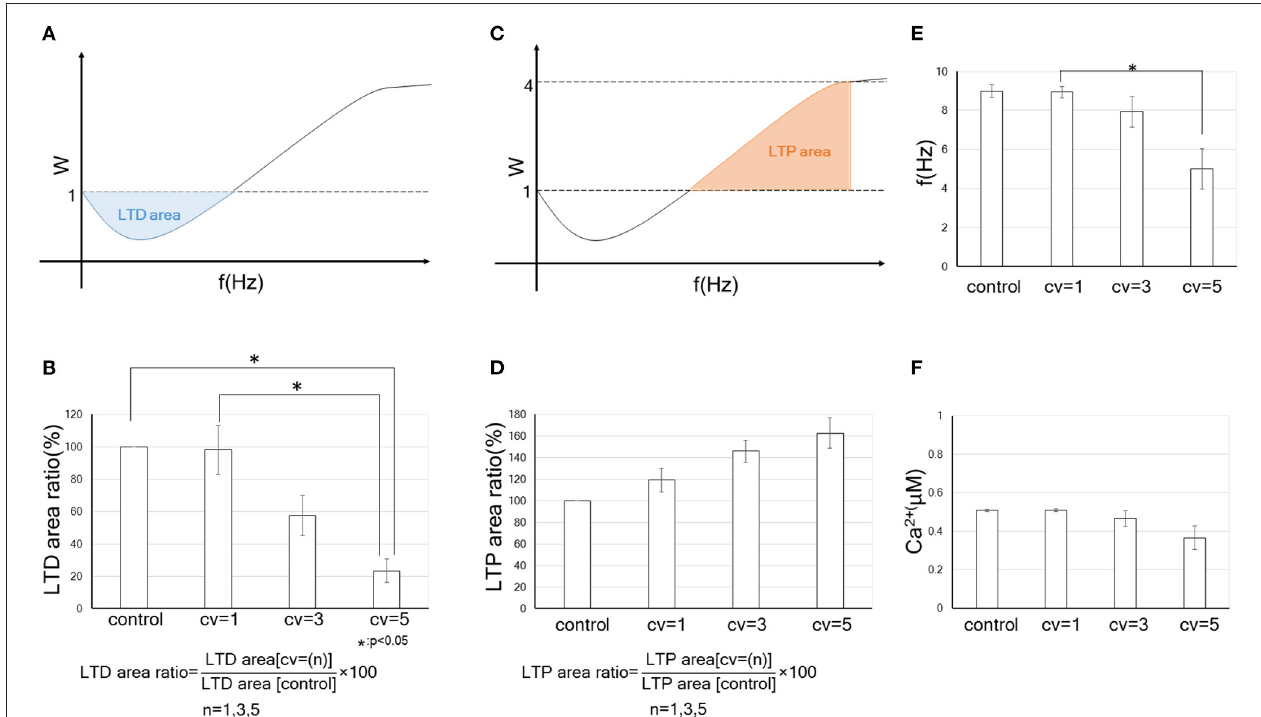
FIGURE 4 | Quantitative data on the change in the synaptic weight by receiving fluctuated background synaptic activity. Error bars indicate the standard error of the mean (SEM). * indicates that the statistical test at the 5% level of significance is significant. (A) A schema of LTD-area. The blue part indicates the LTD-area, whose acreage is obtained by Equation (11). In (B,D) , control is without the fluctuation of background synaptic activity, while CV = 1, CV = 3 and CV = 5 each indicate the results of fluctuations in background synaptic activity with the corresponding CV. We defined “LTD-area ratio” or “LTP-area ratio” as the ratio of the LTD- or LTP- area with the fluctuation in the background synaptic activity and without the fluctuation (see formulas in B,D ). The bar graph shows the LTD-area ratio (%) or LTP-area ratio (%) of the control and synapses receiving fluctuations of the corresponding CV. (B) Relation between the amplitude’s fluctuation of background synaptic activity and tendency to become LTD. (C) A schema of LTP-area. The red part indicates the LTP-area, whose acreage is obtained by Equation (12). (D) Relation between the amplitude’s fluctuation of background synaptic activity and tendency to become LTP. (E) LTD/LTP threshold (Hz) vs. CV of amplitude of background synaptic activity. (F) Relationship between postsynaptic calcium concentration at LTD/LTP threshold and amplitude CV of background synaptic